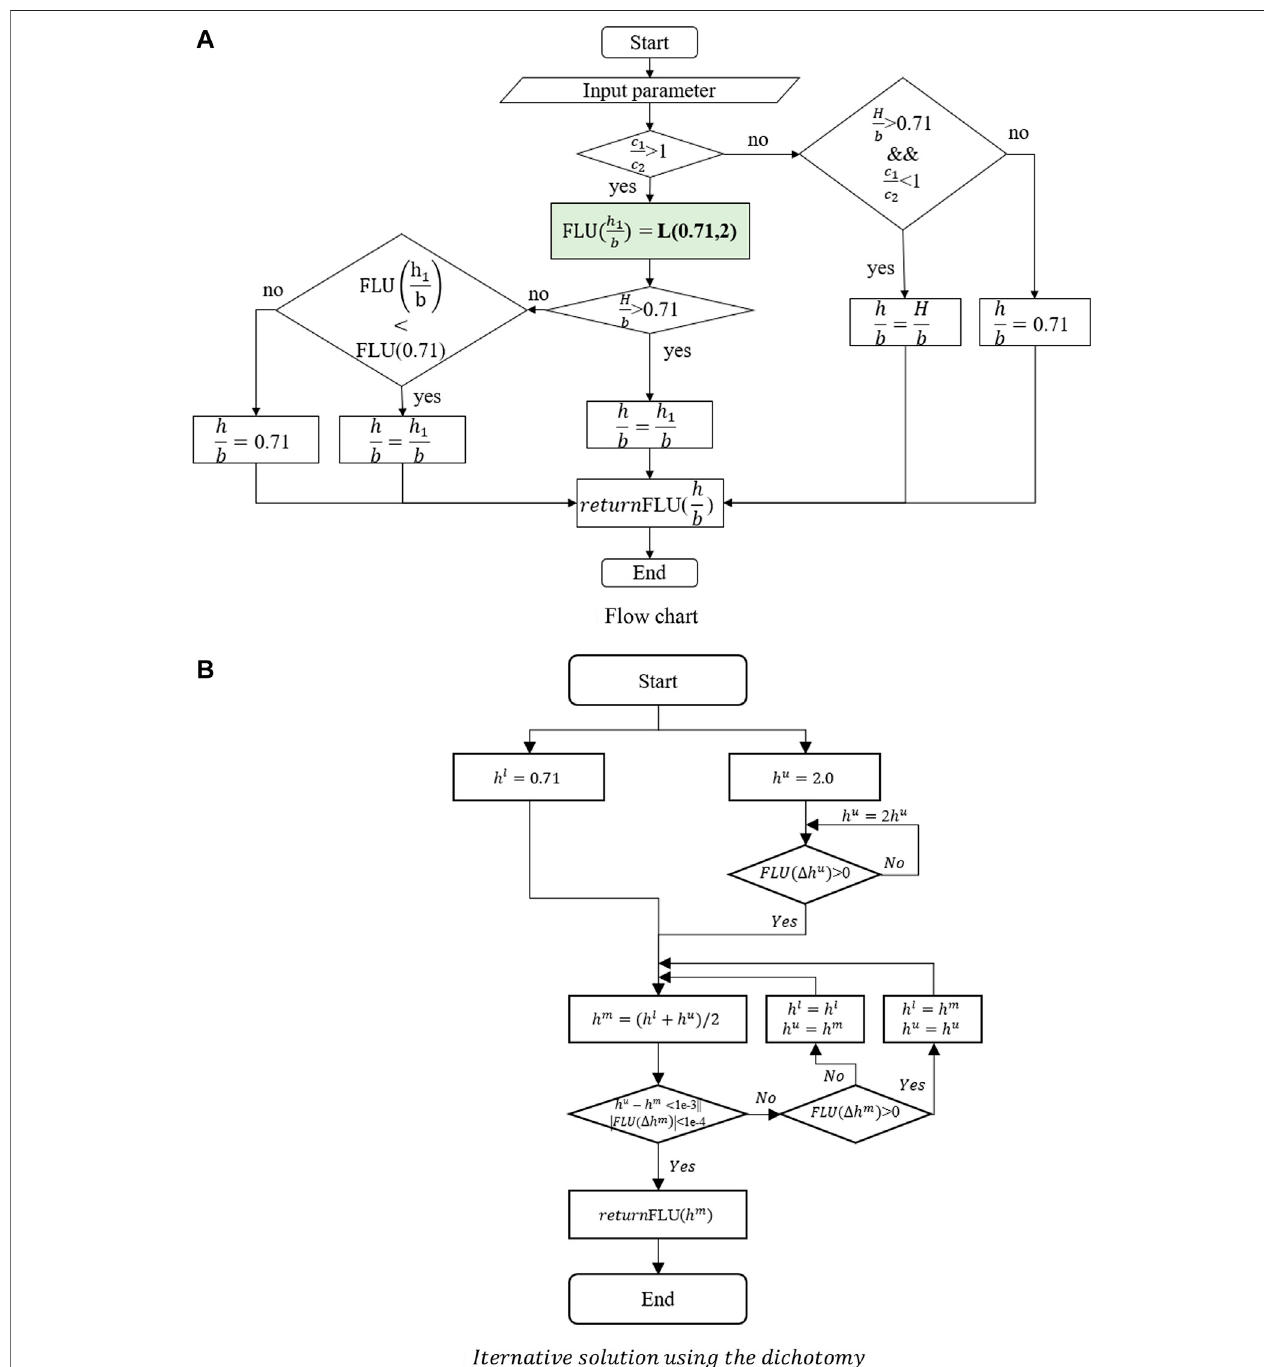
FIGURE 9 | Optimized calculation approach for the bearing capacity of the two-layer clay foundation. (A) Flowchart, (B) Iternativesolutionusingthedichotomy